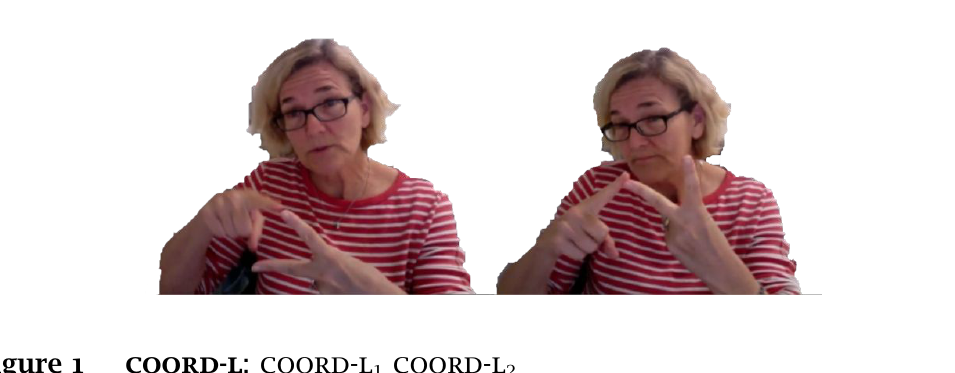
Figure 1 coord-l : coord-l